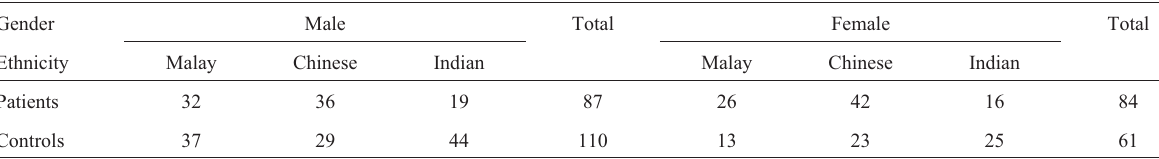
Table 1 - Demographic characteristics of the schizophrenia patients and controls. Gender Male Total Female Total Ethnicity Malay Chinese